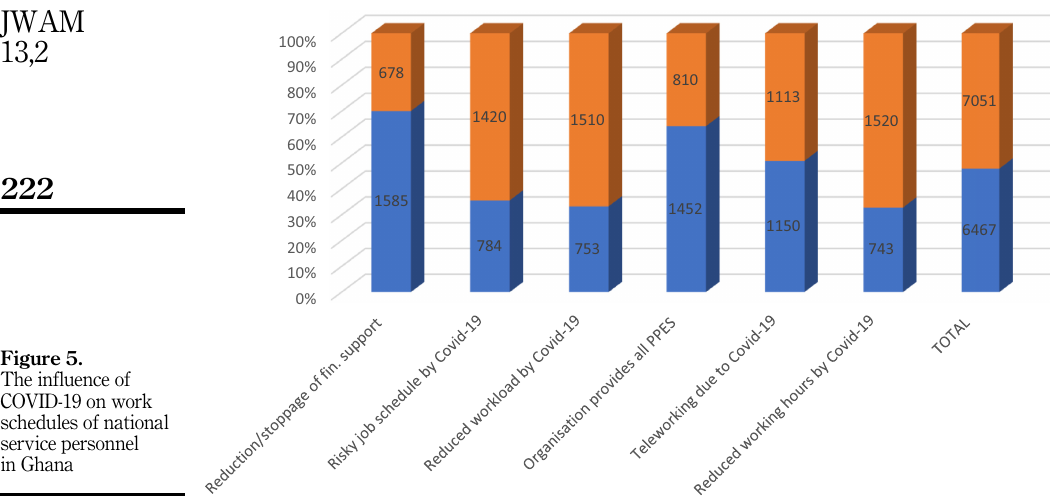
Figure 5. The influence of